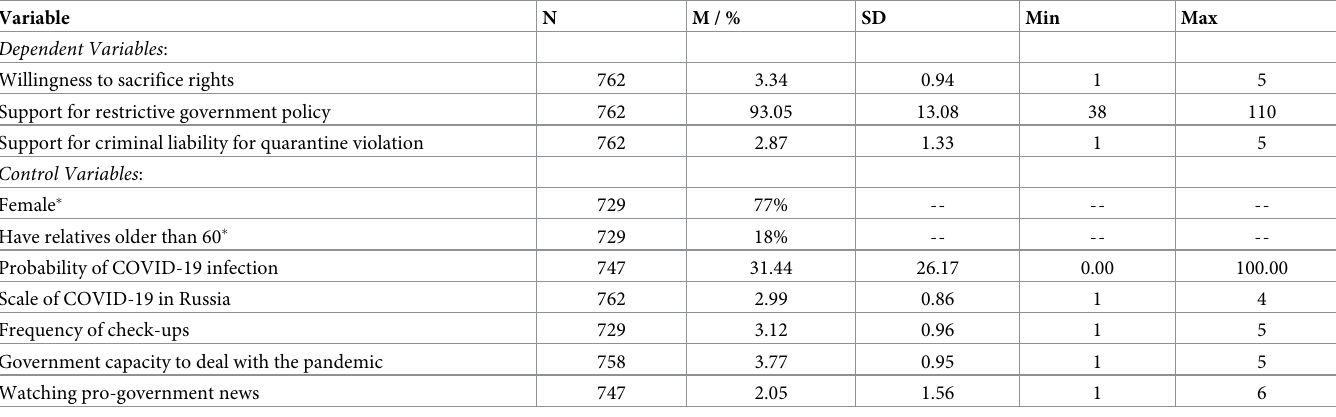
Note : Dummy variables are marked with an asterisk.